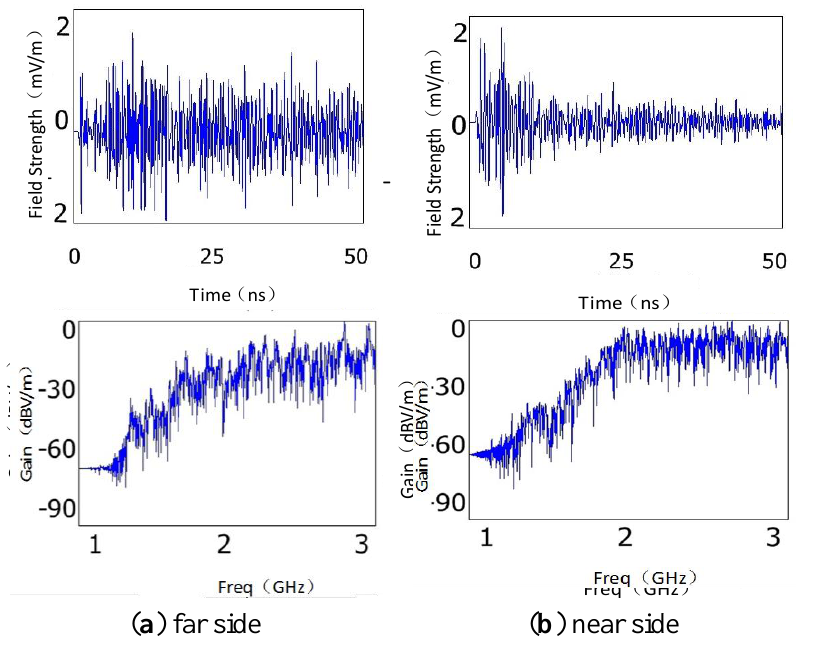
( a ) far side ( b ) near side Figure 13. Simulation results of the influence of insulator on the propagation of EM waves.